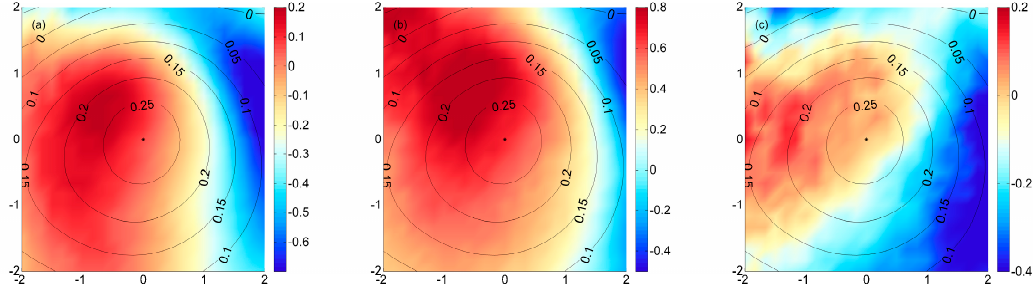
Figure 10. Composites of TMI SLA ( a , color shadings; units: °C), TMI wind speed anomaly ( b , color shadings; units: m · s − 1 ), TMI water vapor anomaly ( c , color shadings; units: mm), and SLA (contours; units: m) for the GW.